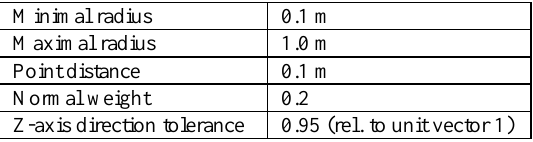
Table 2. Segmentation parameters for cylinder fitting